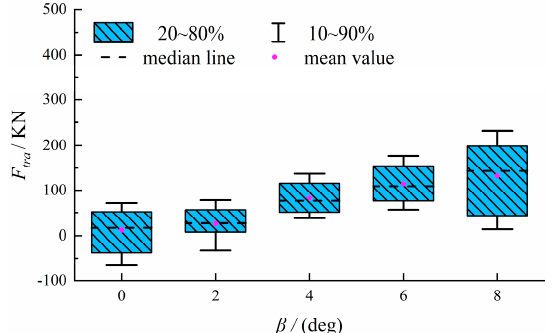
Figure 14. Box plot of F res under different drift angles.